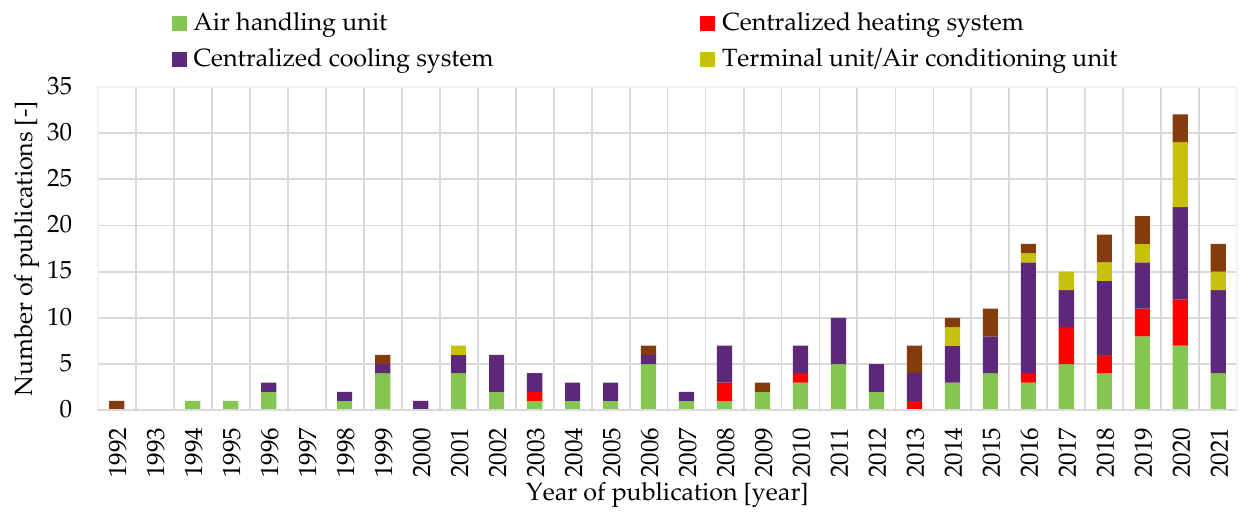
Figure 10. Articles sorted by building system and year of publication. The year 2021 only covers publications until April 2021.